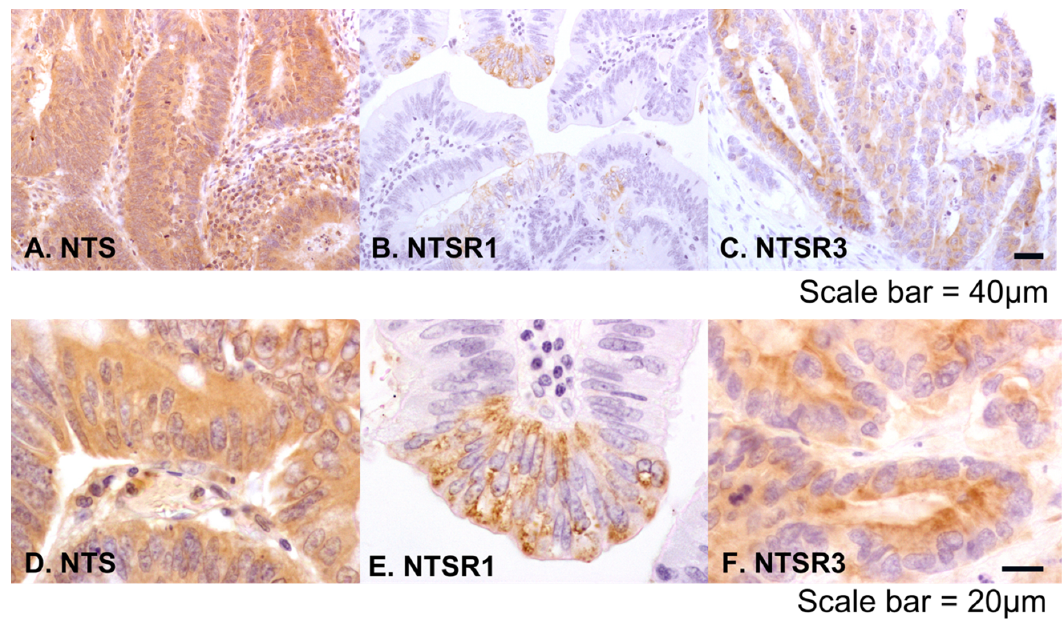
Figure 2. Low magnification peroxidase immunohistochemical staining of colorectal cancer tissue for NTS ( A ), NTSR1 ( B ), and NTSR3 ( C ) at 200 times magnification, internal scale bar = 40 µm. High